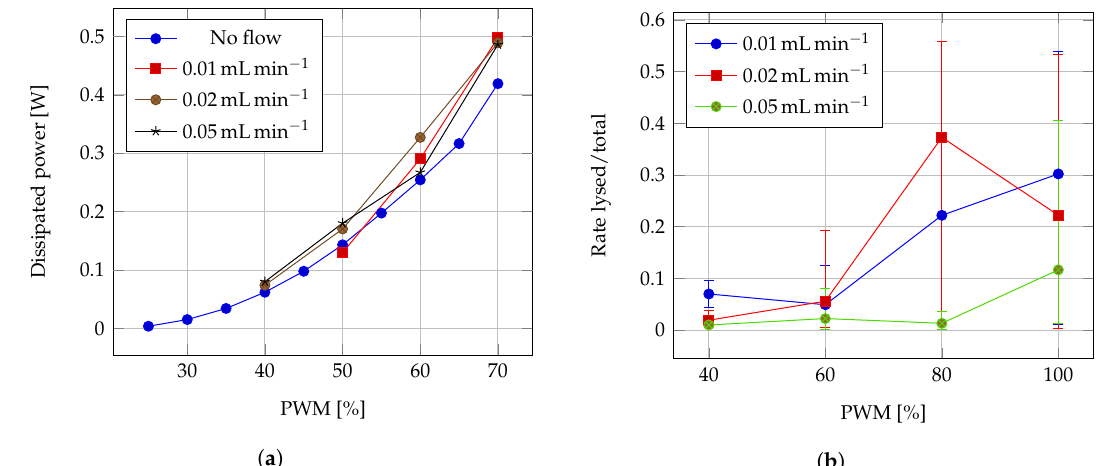
Figure 10. ( a ) Dissipated power on heater during lysis tests. ( b ) Cell lysis performance at different flow velocities.